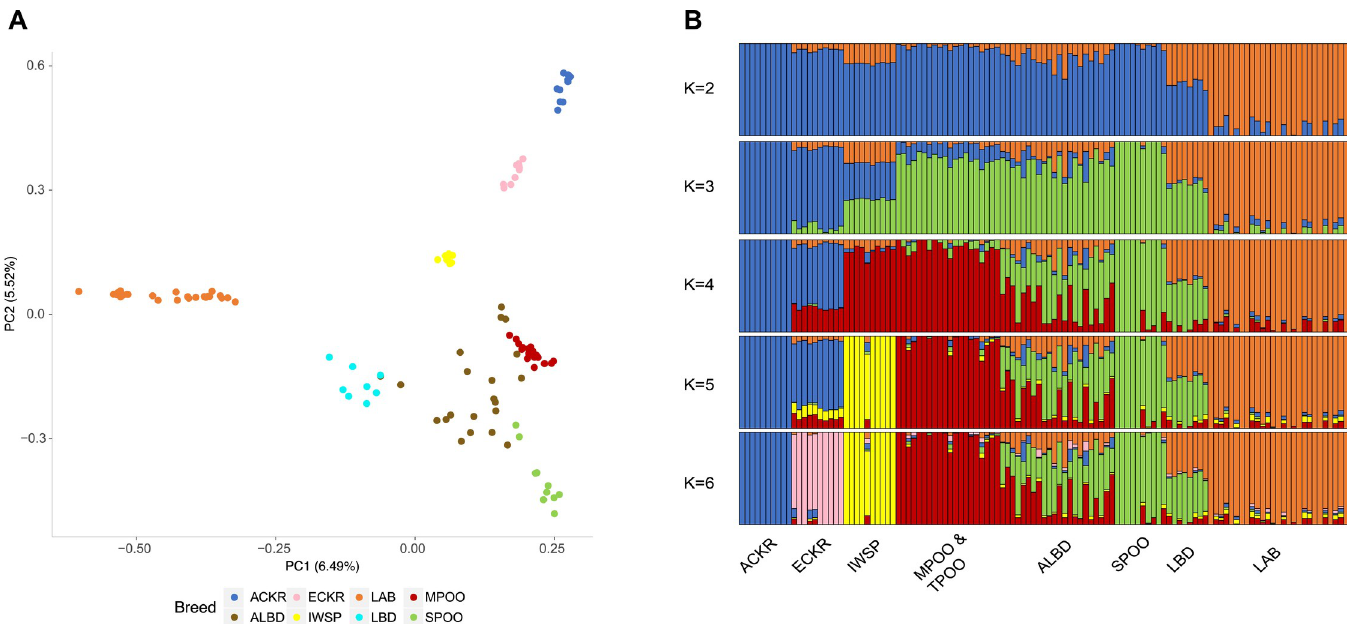
Fig 2. PCA and Admixture analyses. A) PCA analysis plot of the top two principal components (PC1 and PC2), showing the distribution of the eight breeds of interest accounting for a genetic variance of 6.5% and 5.5%, respectively. (B). Admixture analysis representing data for K = 2–6 cluster-based ancestry models. Each bar represents an individual dog, and the color length for each bar represents the proportion of genomic contribution from the founder population.